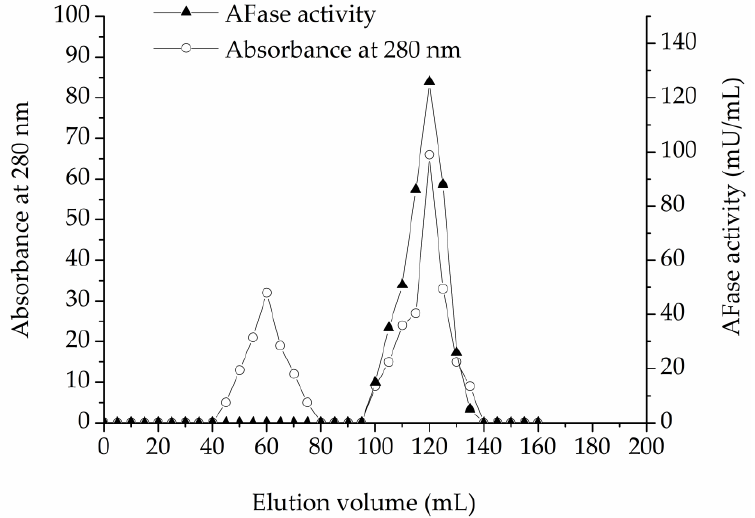
Figure 2. Gel-filtration chromatography of AFase on Sephacryl S-100.